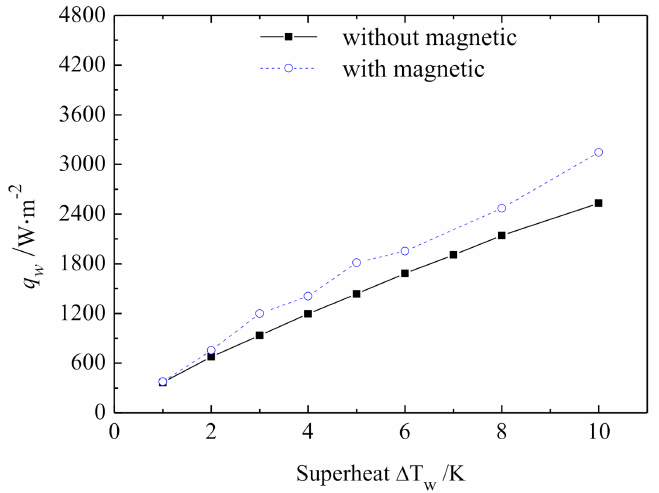
Figure 4. Influence of the magnetic field intensity on the boiling curve under terrestrial